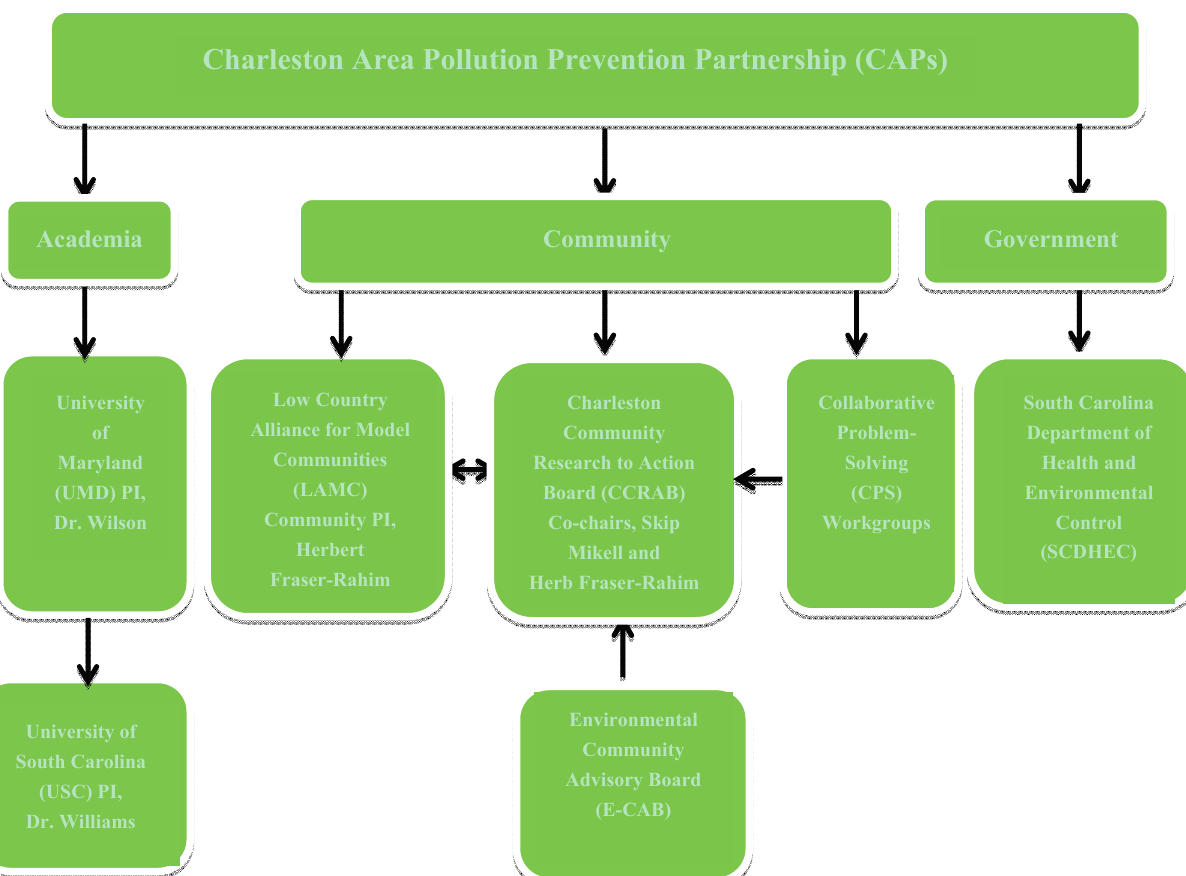
Figure 2. Organizational structure for the community-university